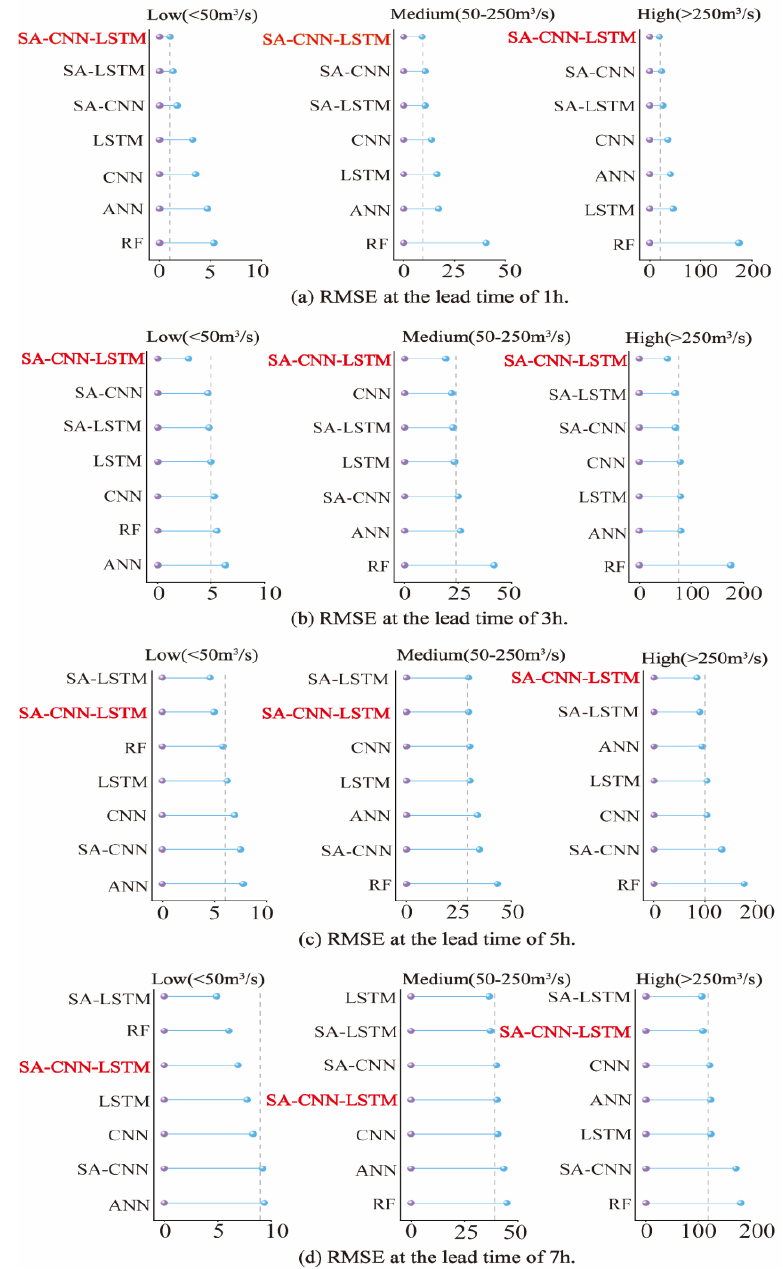
Figure 8. Comparisons of streamflow predictions in three categories of flow for each model at lead times of 1, 3, 5, and 7 h. times of 1, 3, 5, and 7